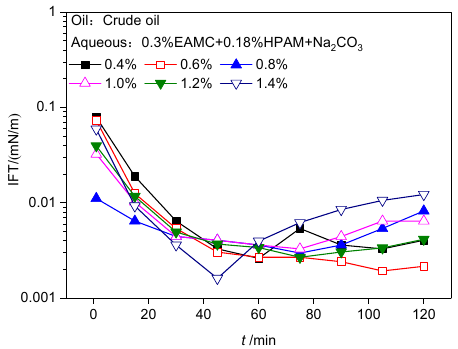
Figure 4. The effect of Na 2 CO 3 on the dynamic IFTs of EAMC and HPAM solutions. The Effect of EAMC on the IFTs of KPS and HPAM Solutions Figure 5 shows the effects of EAMC on the IFTs of KPS and HPAM solutions in a system of the following composition 0.3 wt % total surfactants, 0.18 wt % HPAM and 1.2 wt % Na 2 CO 3 . It must be pointed out that KPS shows lower interfacial active against crude oil than that of EAMC, which comes from the structural difference between KPS and EAMC. EAMC molecule contains two hydrophilic groups (EO groups and carboxylic acid group) and a hydrophobic straight alkyl chain. Therefore, spaces exist at the hydrophobic side of EAMC film and the mixed adsorption of crude oil fraction and EAMC molecules will lead to the tight adsorption film. As a result, IFTs decrease to ultralow values. On the other hand, the petroleum sulfonate molecule has a hydrophobic part with a large size, and no synergism can be observed in the solutions containing only KPS. However, when EAMC has been added to a KPS solution to fill the vacancies of the KPS interface film, even 10 percent of EAMC can reduce the IFT of KPS to an ultralow value.